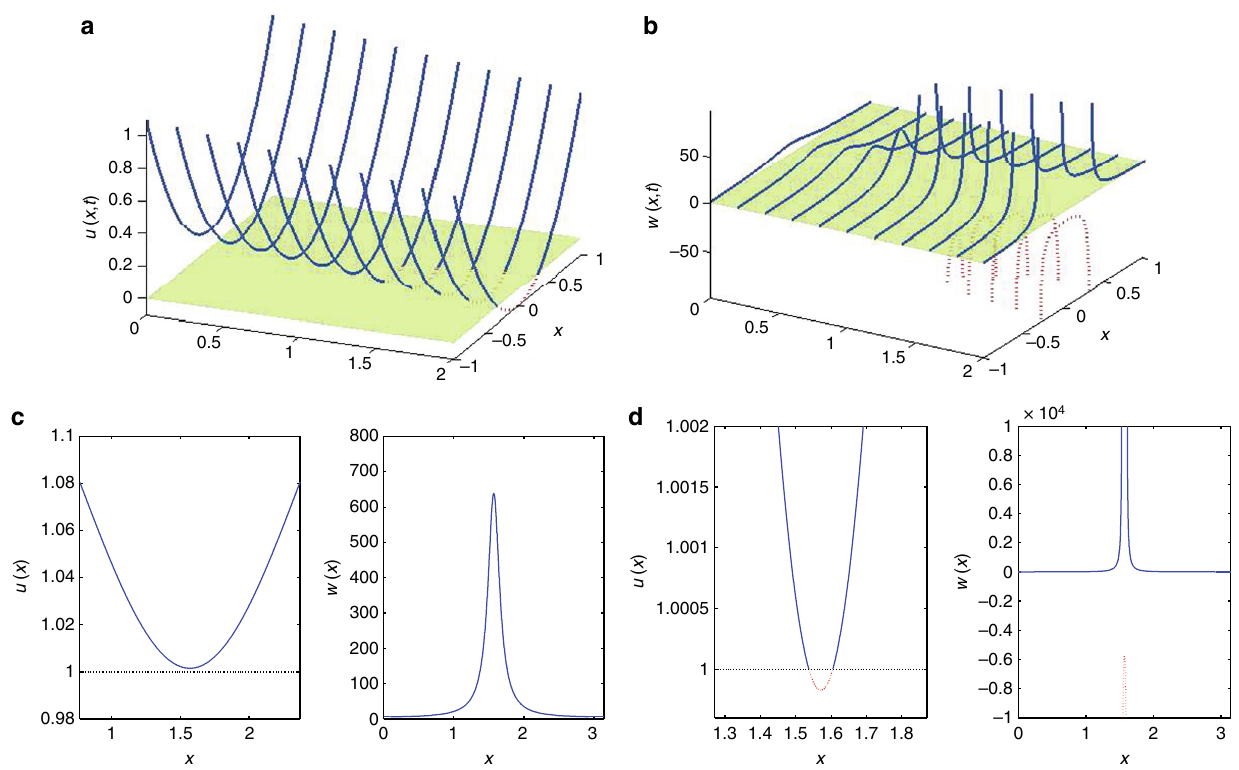
Fig. 2 A geometry for crossing in fi nity for PDEs. a , b An idealized parabola u ( x , t ) a shifting at constant speed without change of shape, crossing the 0 level, b w ( x , t ) = 1/( u ( x , t ) − 0). c , d Solutions u ( x , t ) of Eq. (12) around their crossing of the 1 level, and corresponding w ( x , t ) = 1/( u ( x , t ) − 1) (solutions of Eq. (13)). c Just before crossing, and d just after crossing in fi